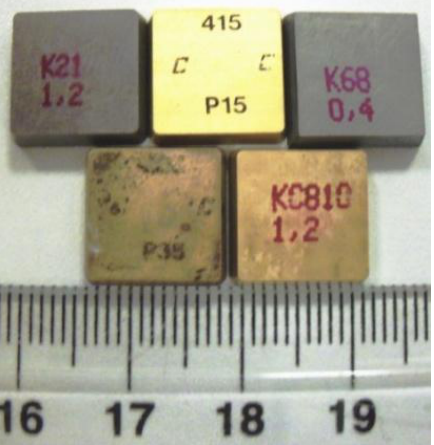
Figure 3. Types of employed coated and uncoated carbide inserts (cm scale with mm